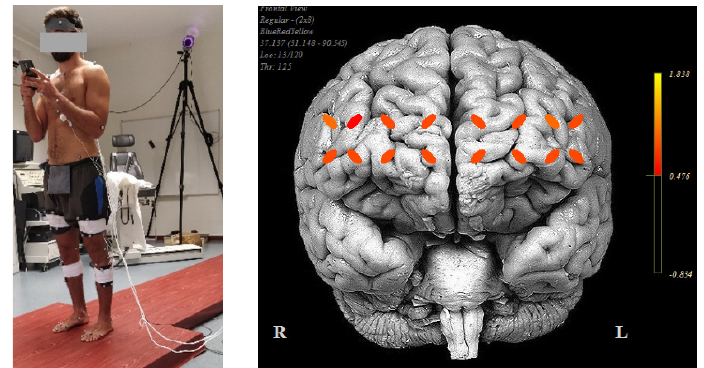
Figure 1. Prefrontal cortex activation (oxyhemoglobin) during difficult dual-task